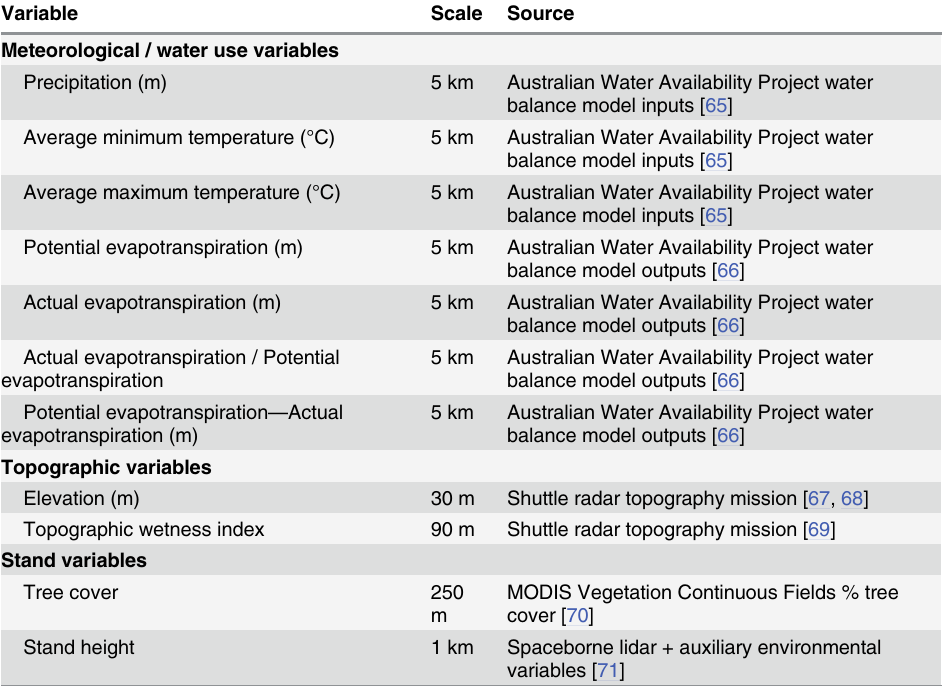
Table 1. Environmental variables used to explore relationships between drought impact patch char- acteristics (as a measure of drought impact intensity) and moisture gradients associated with meteo- rology, water use, and terrain, as well as stand characteristics influencing water